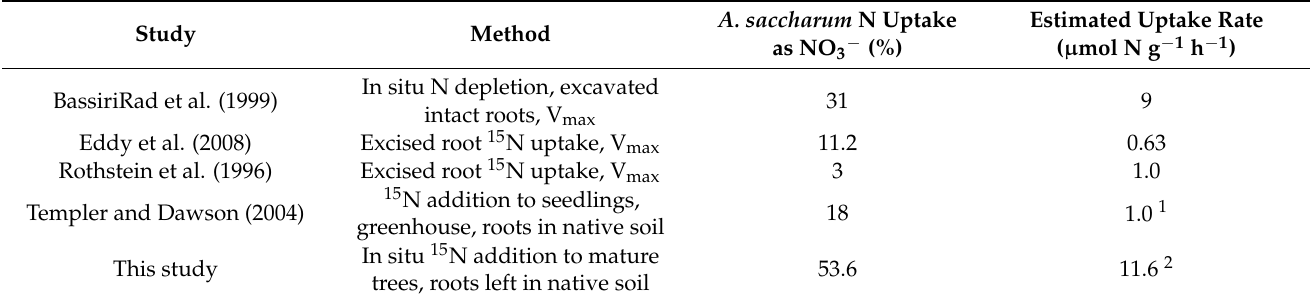
Table 2. All available estimates of the percent of total uptake of mineral N as NO 3 − and estimated N uptake rates ( µ mol